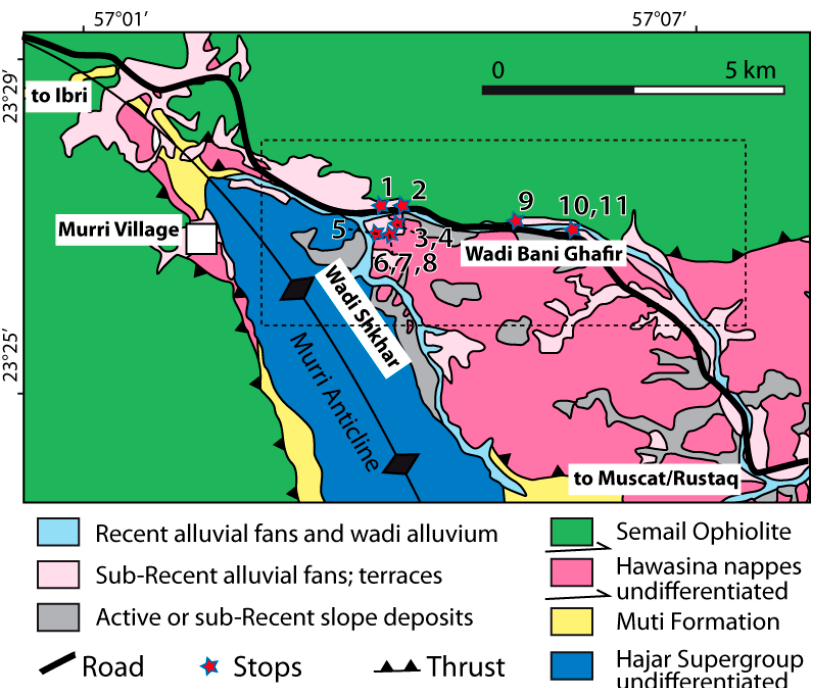
Figure 2. Simplified geological map of the study area, drawn after [15] (see white box in Figure 1 for location). The numbers 1 to 11 are the thrust faults as they are shown in Table 1. Optical Stimulate Luminescence (OSL) dating sample is at position next to fault 5. The rectangle marked by the black, dashed line shows the outline of Figure S2, depicting each thrust with the respective slicken lines.